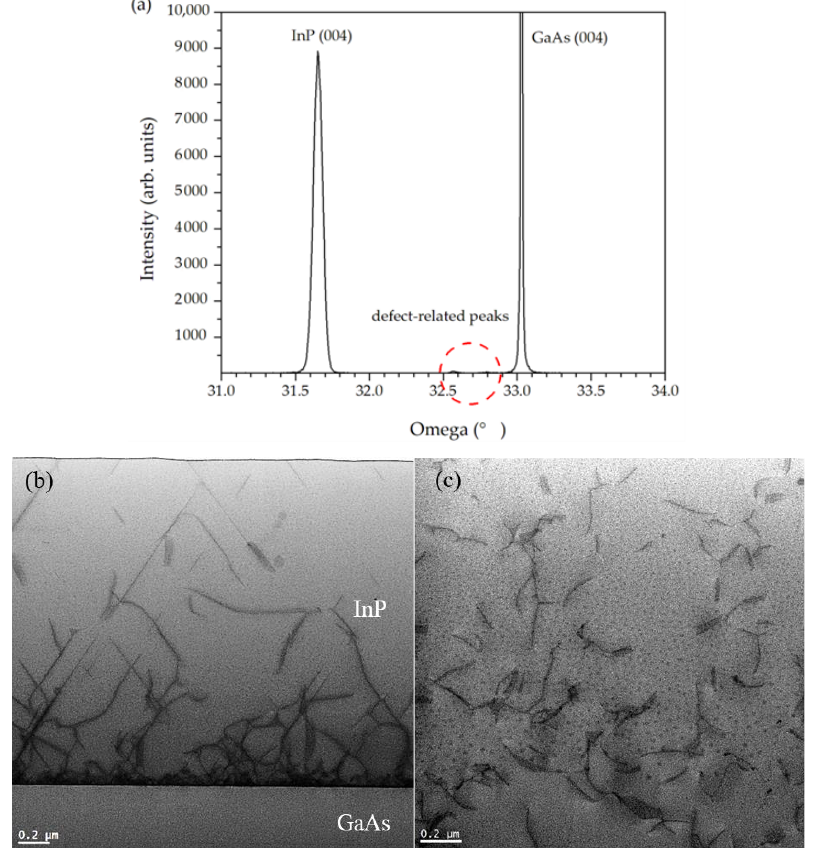
Figure 2. The characterization results of an InP/GaAs virtual substrate grown using a two-step method, including ( a ) an ω - 2θ XRD scan; ( b ) a cross-sectional TEM image; ( c ) a plan-view TEM image.